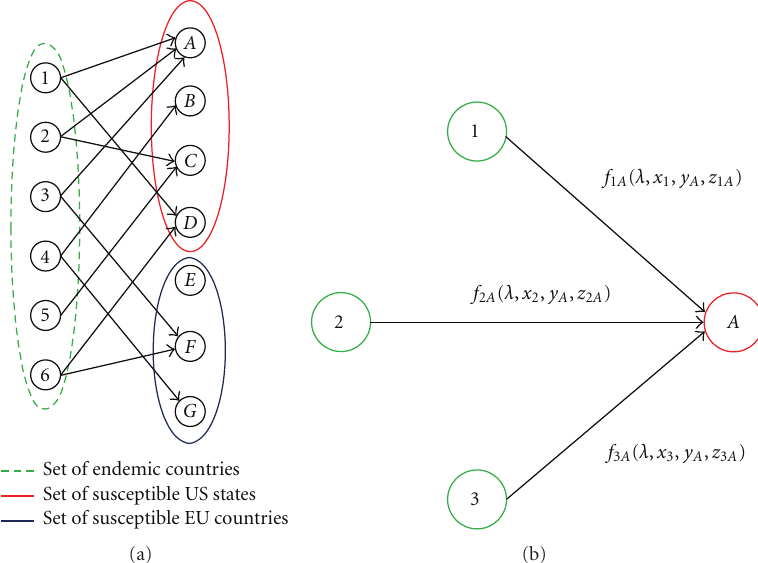
Figure 1: (a) Bipartite network connecting endemic regions to susceptible regions: the susceptible U.S. and Europe nodes represent mutually exclusive sets; (b) link-based functions: these predict the number of infections at susceptible node A, attributed to each adjacent endemic region (1, 2, and 3).